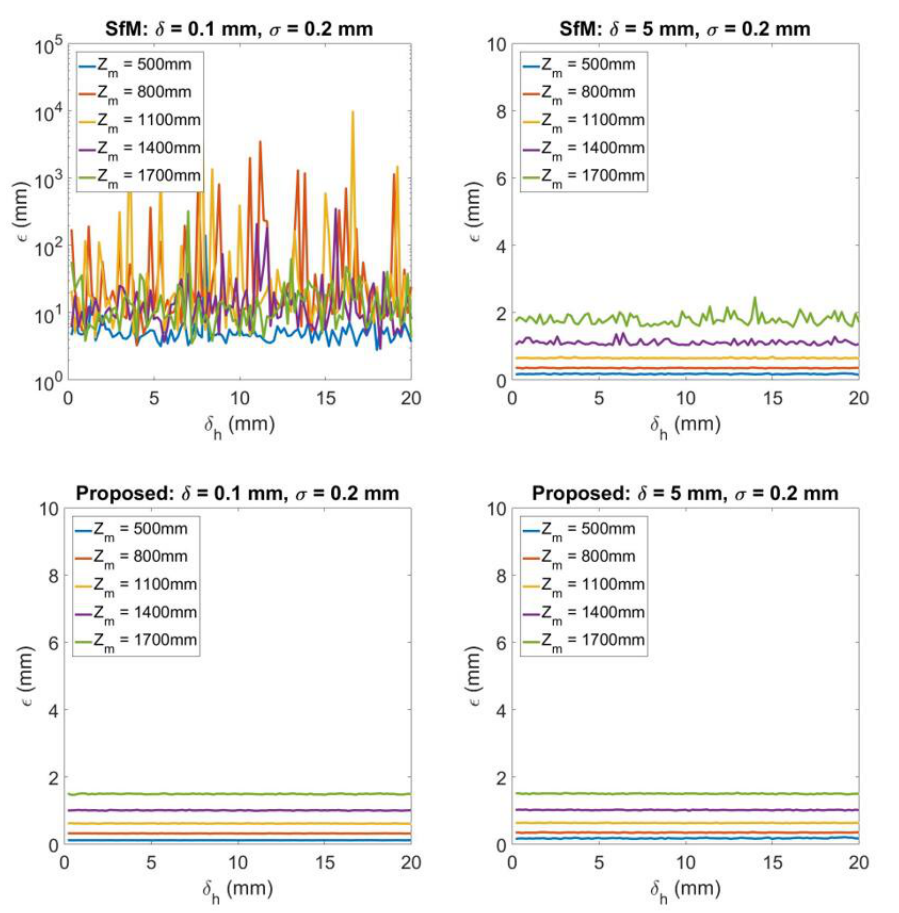
Figure 11. 3D reconstruction error of different error δ h = 0.2,0.4, . . . ,20 for camera to road surface distance h. From left to right each column represents the results for δ = 0.1,5 respectively. For